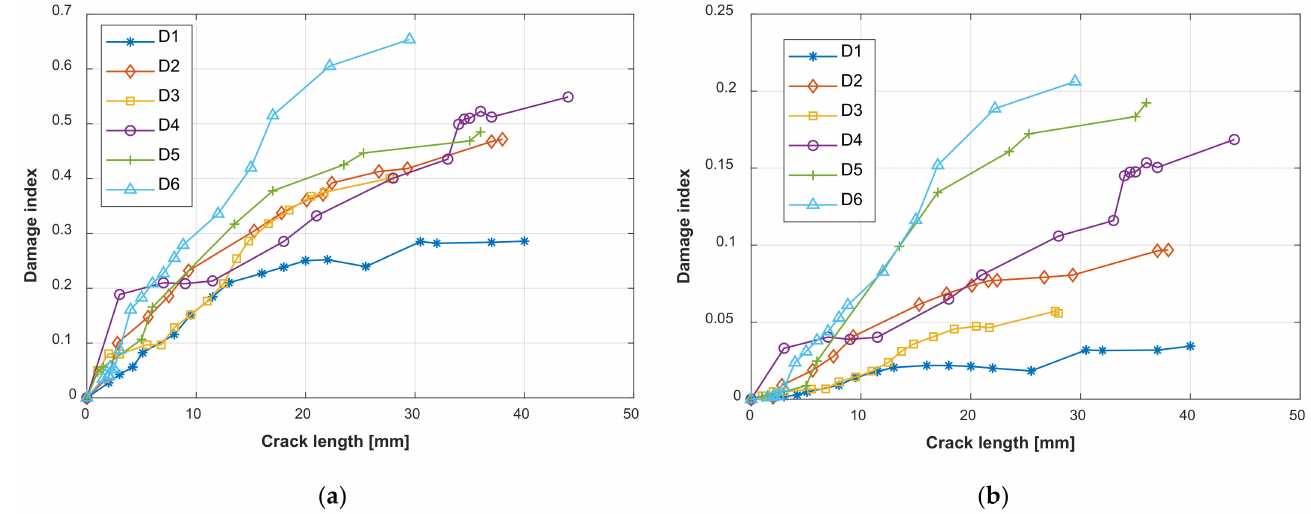
Figure 16. Widely used damage indexes extracted from the GW signal: ( a ) Root mean square deviation damage index; ( b ) Drop-in correlation coefficient damage